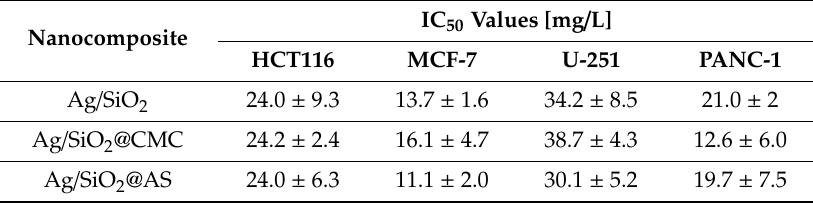
Table 6. Anti-proliferative activity (IC 50 values) of the tested nanocomposites against di ff erent human cancer cells.